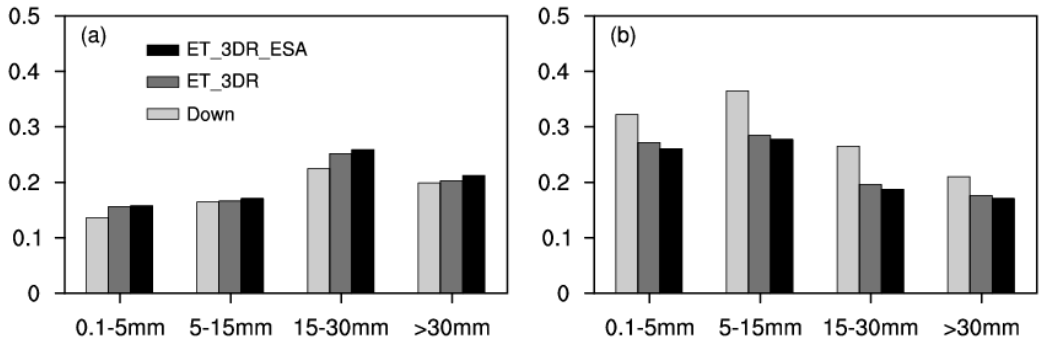
Figure 11. 12-h accumulated precipitation ( a ) equitable threat score (ETS) and ( b ) Brier score (BS) for the three ensemble forecast systems.